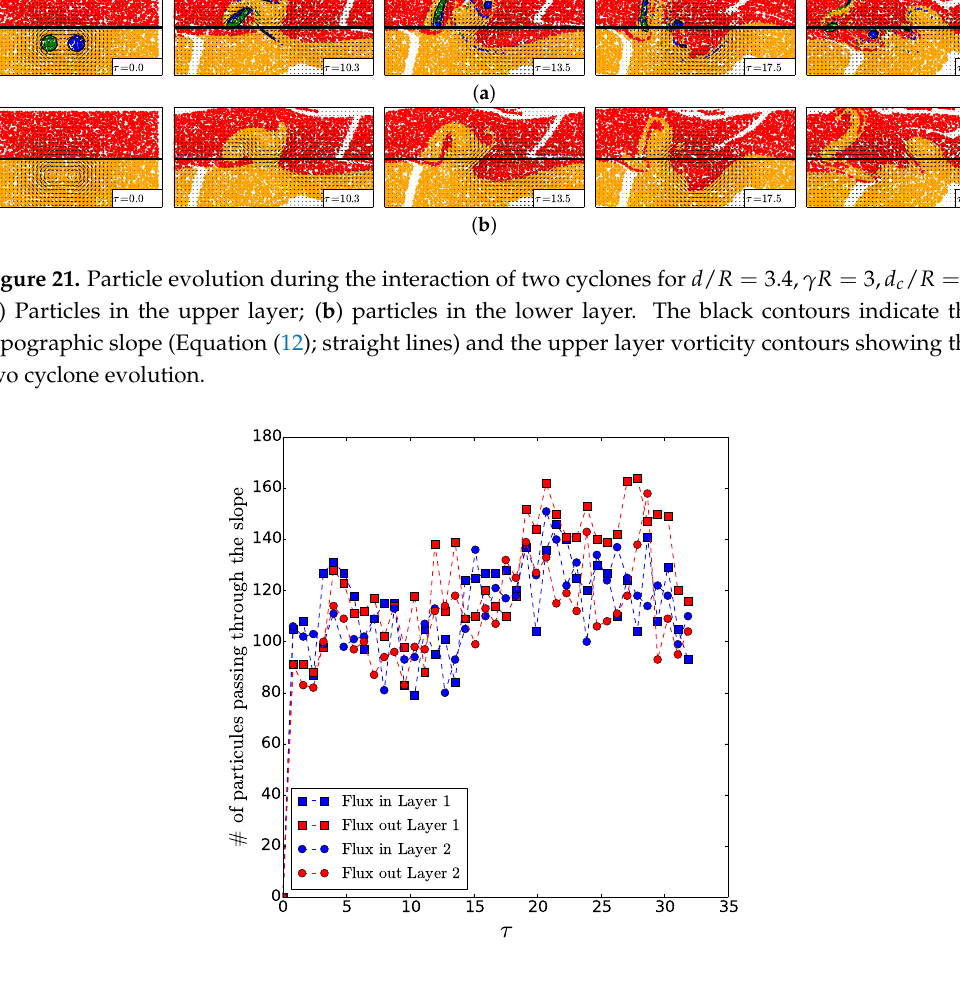
Figure 22. Number of particles crossing the slope inward and outward, in both layers, during the interaction of two cyclones for d / R = 3.4, γ R = 3, d c / R =